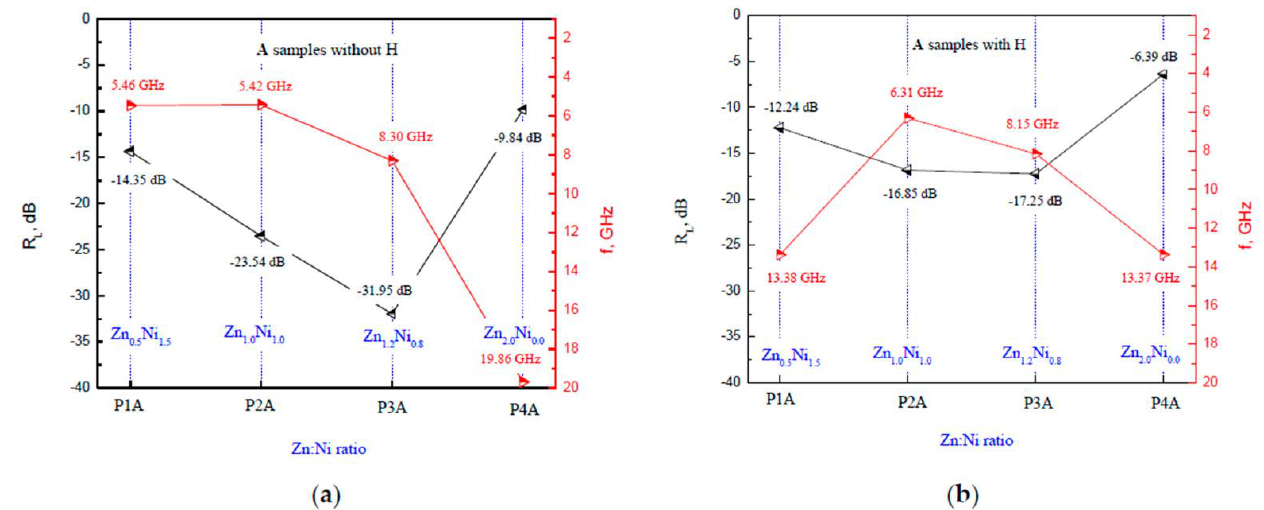
Figure 6. The main reflection loss peaks for the A series of samples depending on the Zn:Ni ratio ( a ) without a magnetic field and ( b ) with an external magnetic field applied. ( a ) without a magnetic field and ( b ) with an external magnetic field